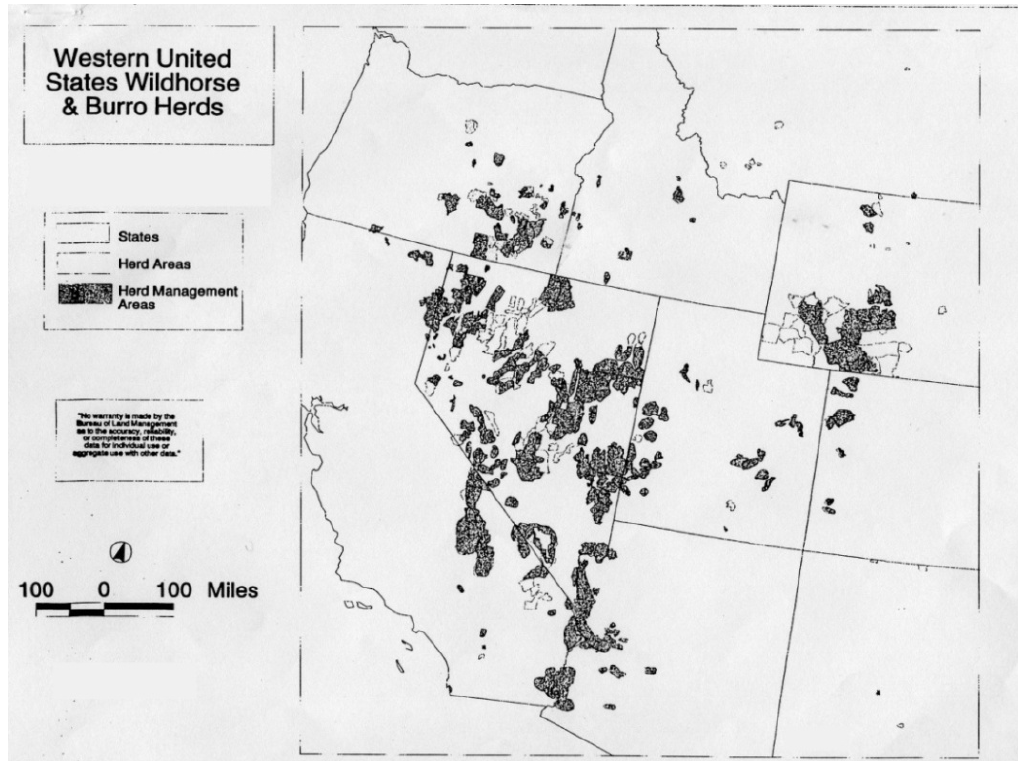
Figure 4. Map Highlighting Wild Horse Areas in the American West